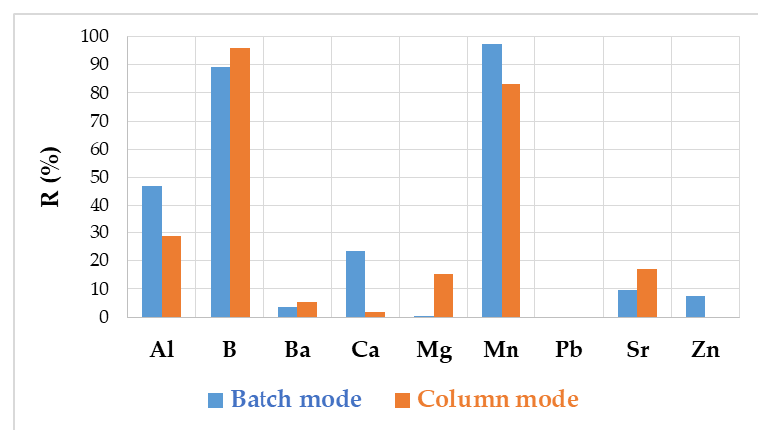
Figure 3. The effect of wastewater purification using hybrid chitosan-zirconium hydrogel beads on the effluent composition.